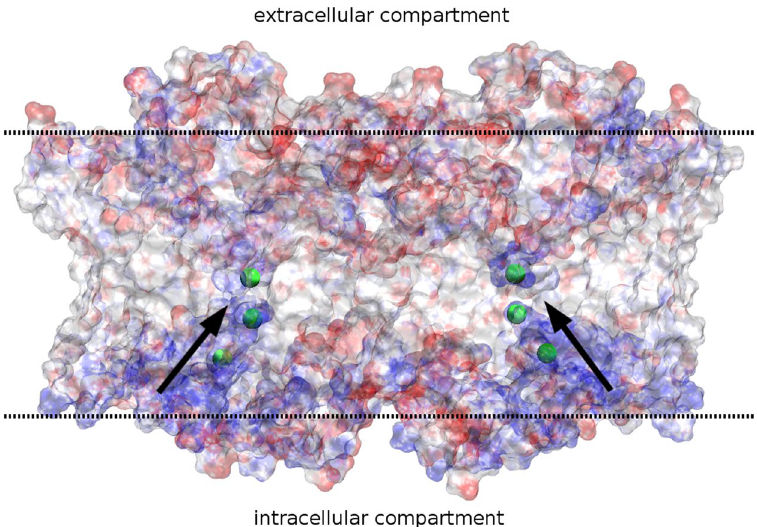
Figure 2. Electrostatic potentials of the TM part of the human ClC-Kb channel. View of the channel through the longitudinal axis of the membrane represented by dashed lines. The electrostatic potential calculated for the full system (protein and membrane) is mapped onto the protein surface from − 5 (red) to + 5 (blue) kcal. mol − 1 . Arrows represents the ion path from the intracellular compartment to the ion gate. A transparent surface representation is used in order to show the channel interior.